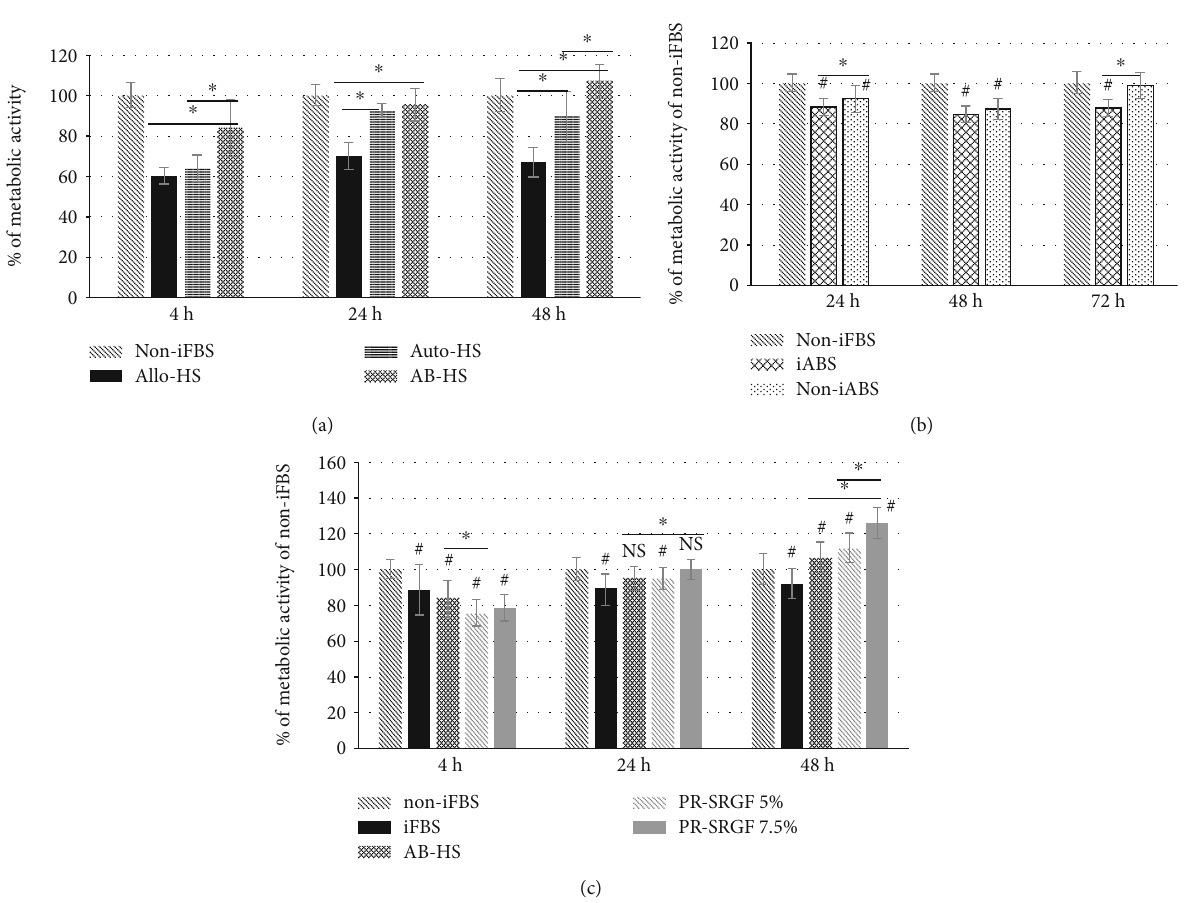
Figure 3: Metabolic activity of MSCs cultivated in di ff erently supplemented media. (a) Cells in the media supplemented with 5% allogenic human serum (allo-HS), 5% autologous human serum (auto-HS), and 5% human serum derived from donor of the AB blood group (AB- HS) (results compared to % of non-iFBS). All the results were signi fi cantly di ff erent to non-iFBS ( p < 0 : 05 ). (b) Metabolic activity of MSCs cultivated in media with non-iFBS, heat inactivated adult bovine serum (iABS), or noninactivated adult bovine serum (non-iABS). #Signi fi cant di ff erence between non-iFBS and samples ( p < 0 : 05 ). (c) Cells in the media supplemented with 5% heat inactivated FBS (iFBS), 5% human AB serum (AB-HS), and 5% or 7.5% platelet releasate (PR-SRGF) supplement after 4 – 48 h (results compared to % of non-iFBS). NS: nonsigni fi cant di ff erence to non-iFBS control. ∗ Signi fi cant di ff erence between samples. #Signi fi cant di ff erence between non-iFBS and samples ( p < 0 : 05 ), based on one factor ANOVA with post hoc Fischer LSD